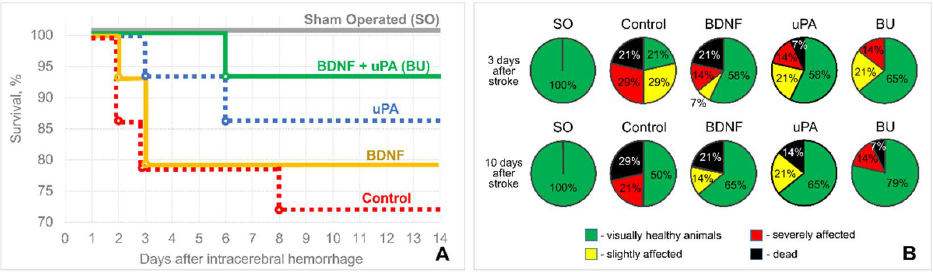
Figure 1. Animal survival ( A ) and the neurological percentage structure ( B ) of experimental groups at 3 and 10 days following the intracerebral hemorrhage (according to the neurological testing data). BDNF, brain-derived neurotrophic factor; BU, BDNF + uPA; SO, sham-operated; uPA, urokinase-type plasminogen activator.